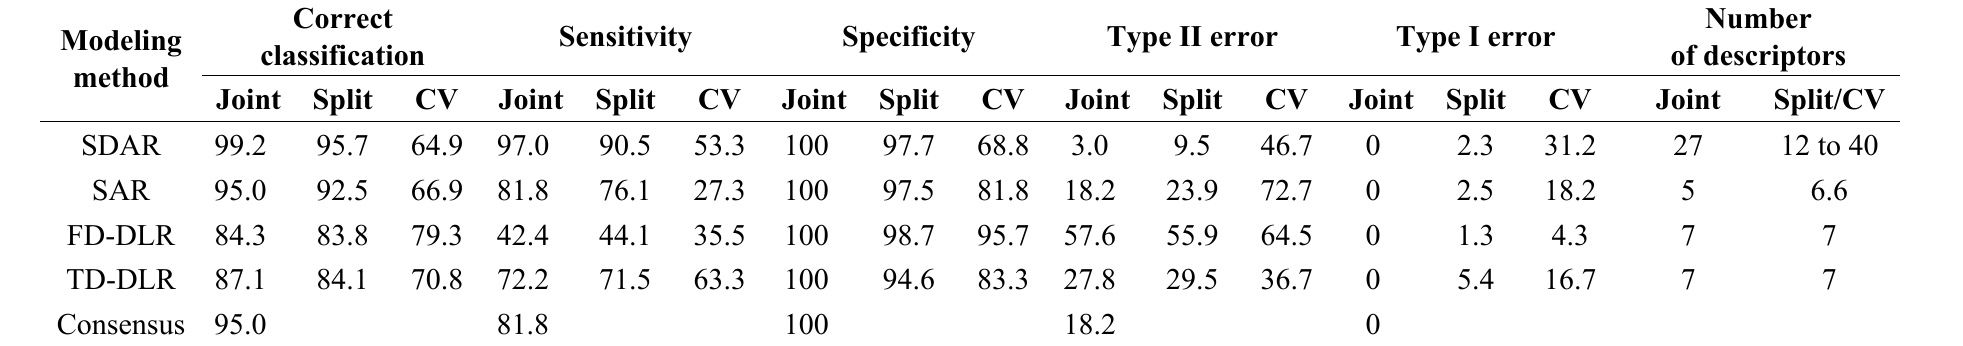
Table 4. Comparison of SDAR-, SAR- and DLR-modeling *